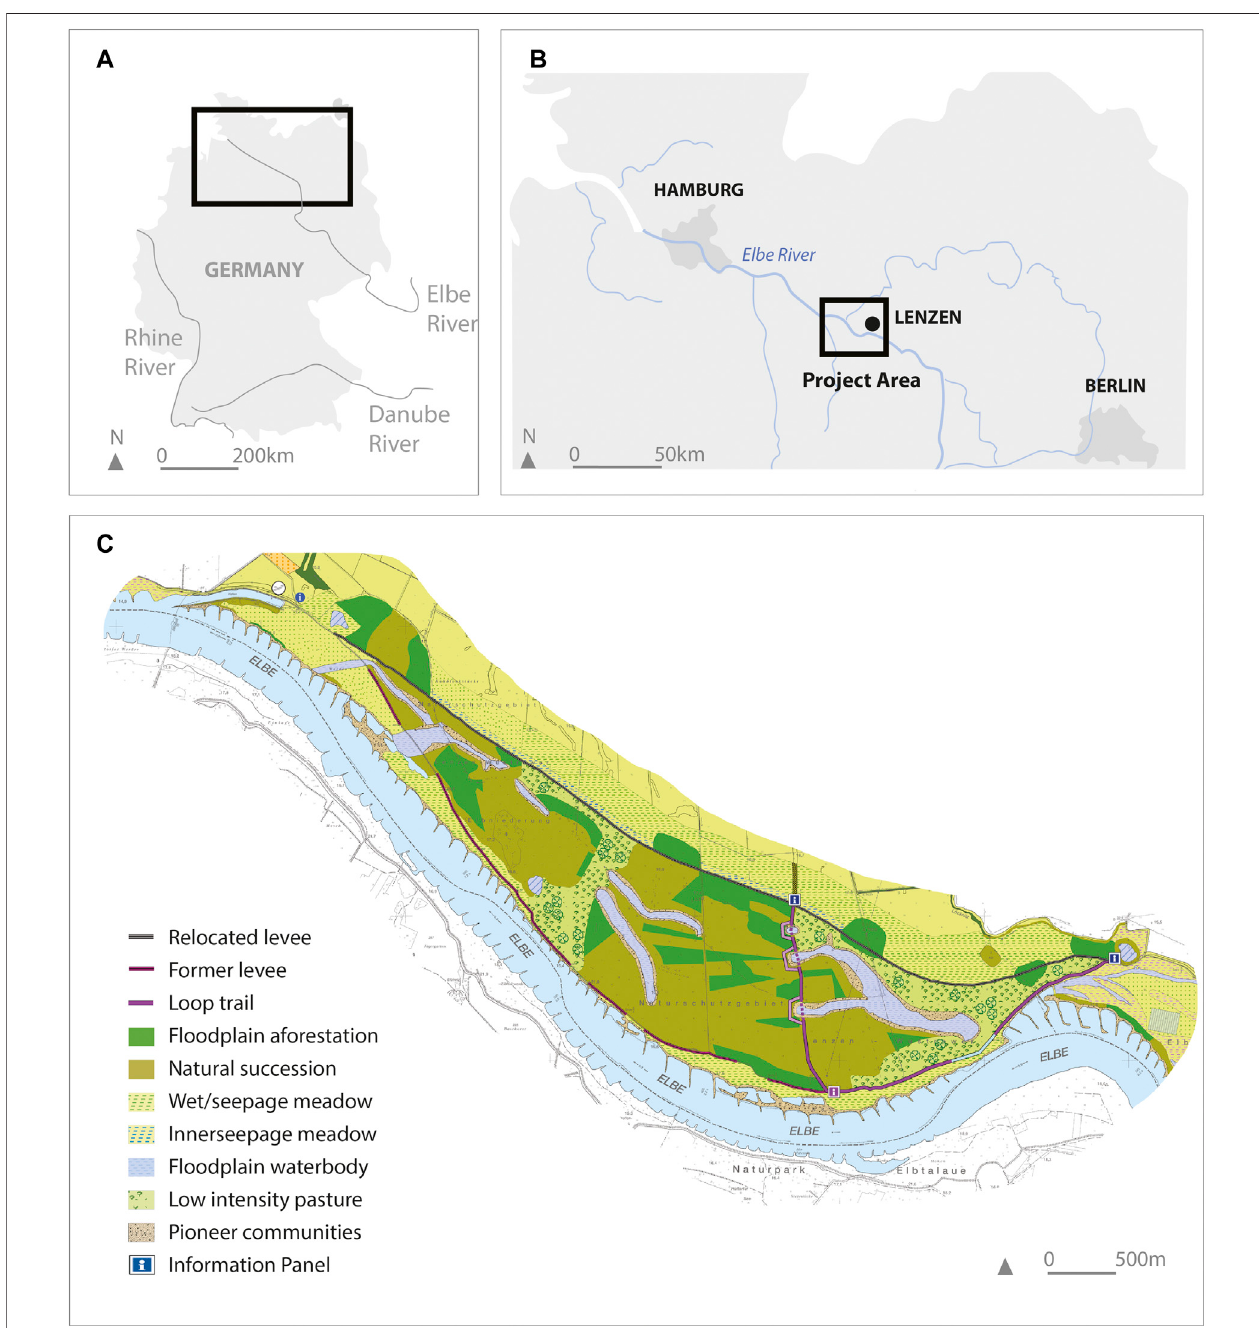
FIGURE 7 | Elbe River Levee Setback Project, Germany. (A) Location Map, (B) Regional Map, and (C) Elbe River Levee Setback Restoration Project.